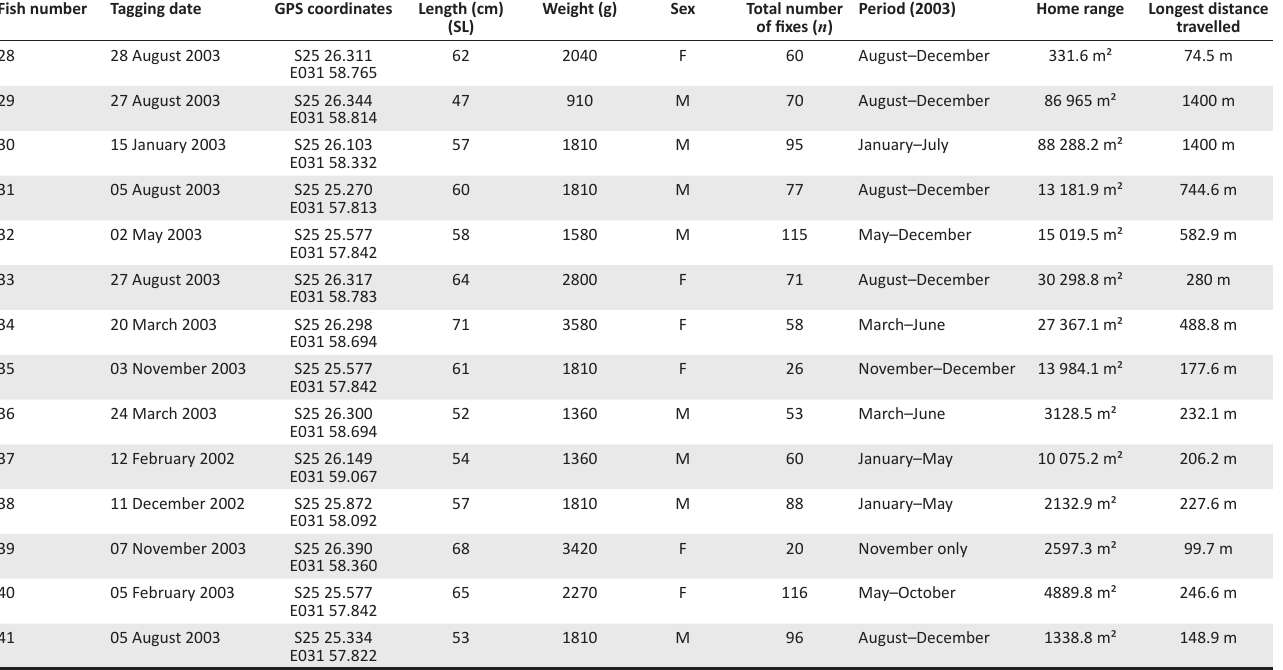
TABLE 1 (Continues...): Individual fish collection, release and radio-tagging data (home range and longest distances). Fish number Tagging